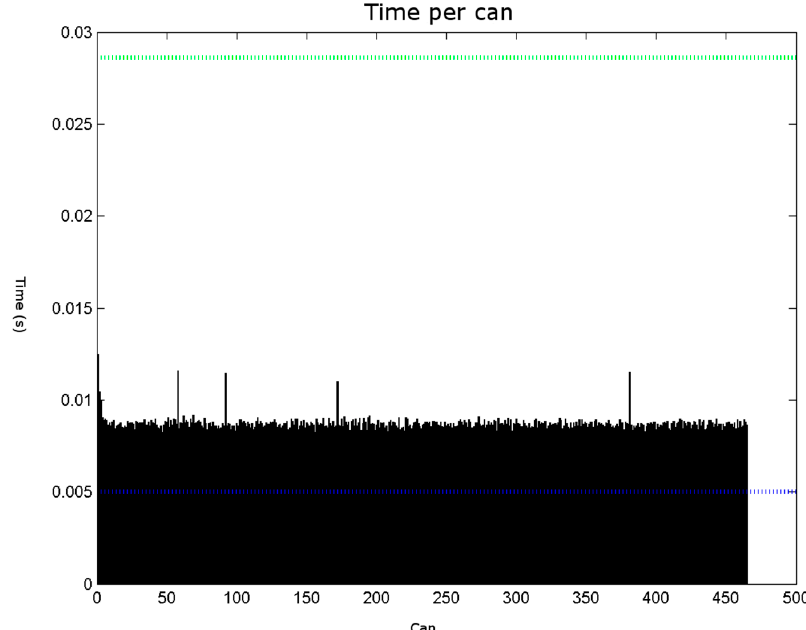
Figure 22. The time spent on each sample can is shown in seconds. The blue line corresponds to 1/200 s. The green line corresponds to 1/35 s. The shape extraction is fast enough to process 35 cans per second but insufficient to address all of the acquired frames.